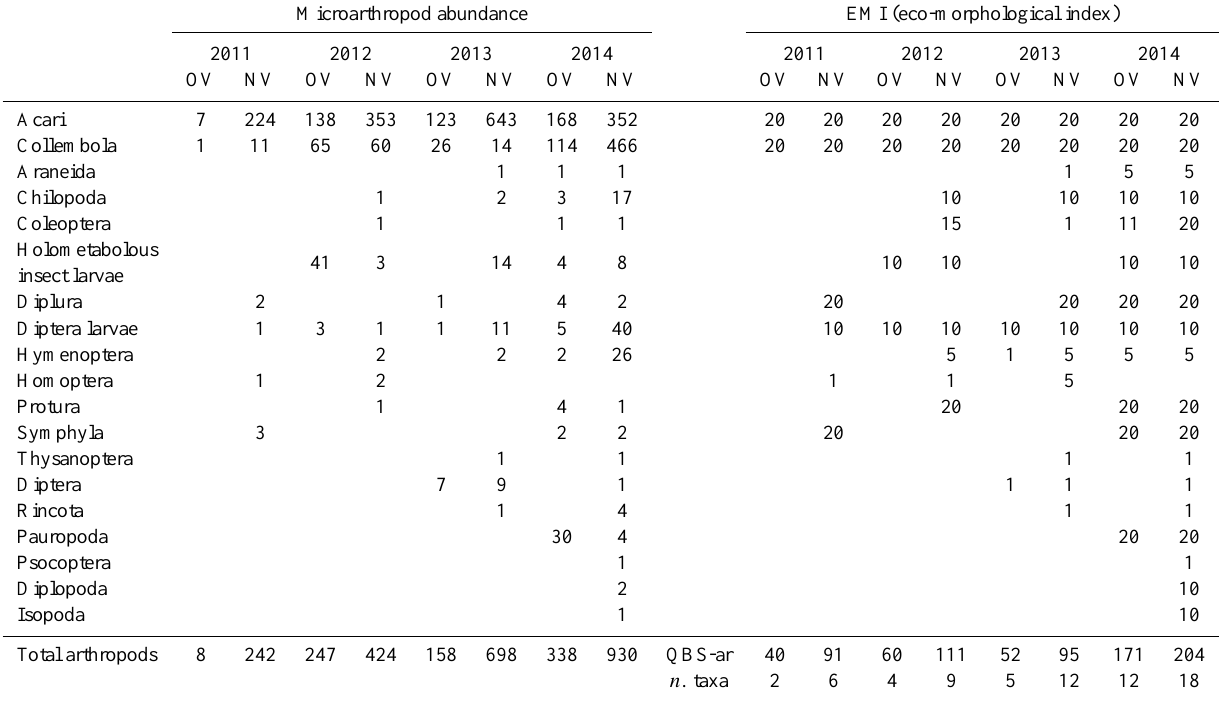
Table 3. Abundance of soil microarthropods, number of taxa and QBS-ar index (as resulting from the sum of the EMI scores) in the old (OV) and in the new (NV) vineyard